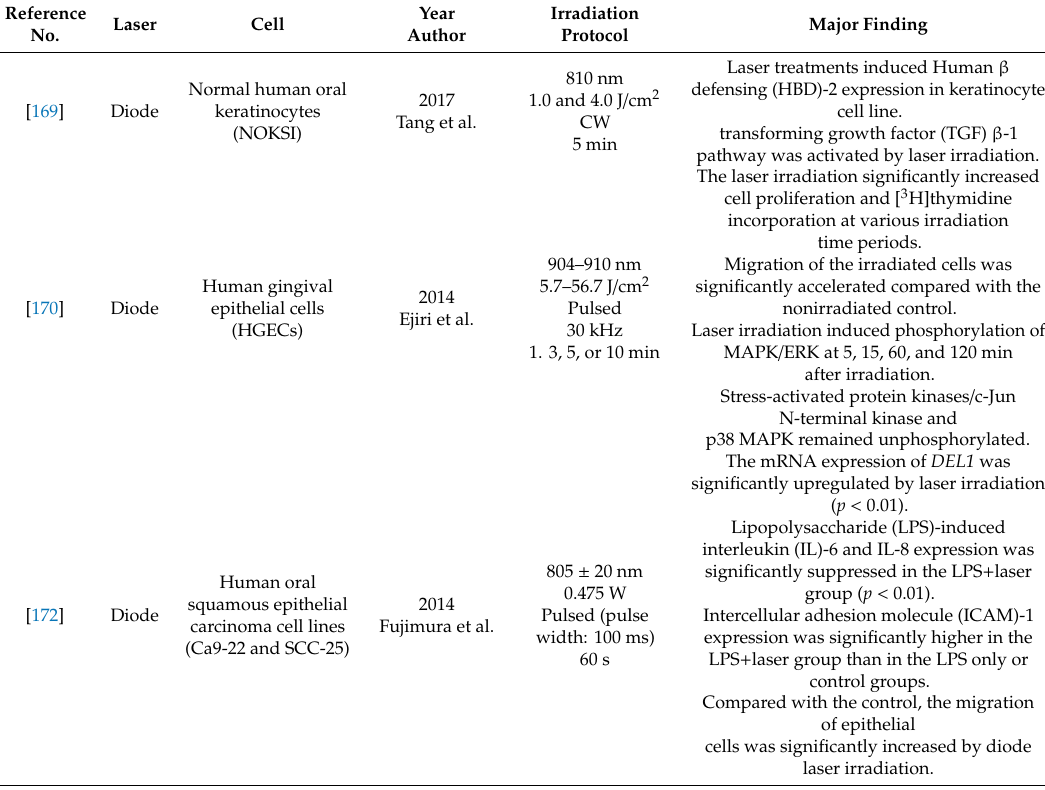
Table 6. Summary of the e ff ects of laser irradiation on epithelial